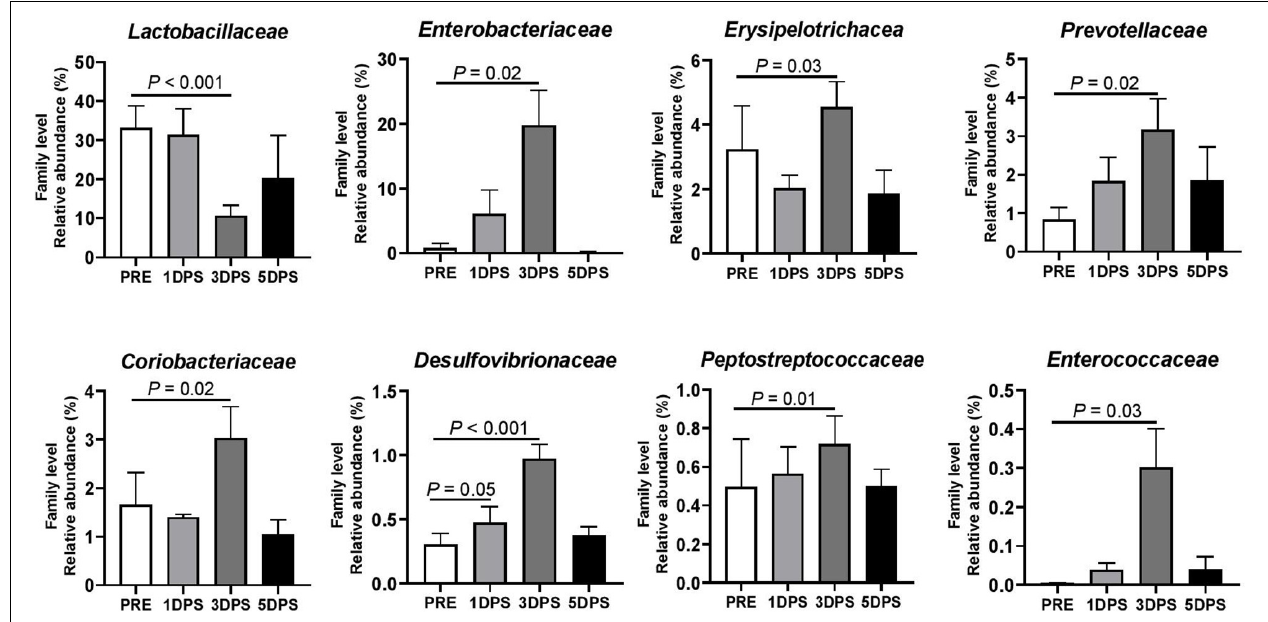
FIGURE 6 | Stroke resulted in family level perturbations in gut microbiota between pre- and poststroke in MCAO pig model. Bacterial families showed changes in abundance ( P ≤ 0.05) during the acute stage of stroke. P -value: Paired t- test comparing the mean prestroke values vs. each time point poststroke. Prestroke (PRE, n = 7), 1 day poststroke (1 DPS, n = 7), 3DPS ( n = 6), and 5 DPS ( n =